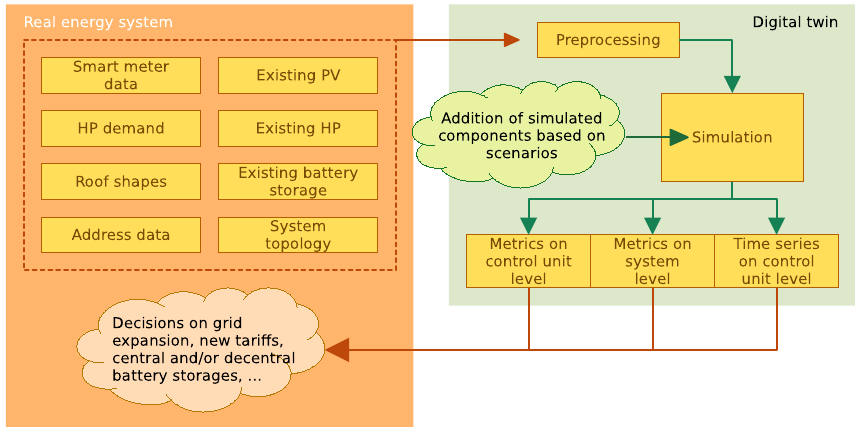
Fig. 4 Required data used by the digital twin and conceptual data flow including the input and output for the